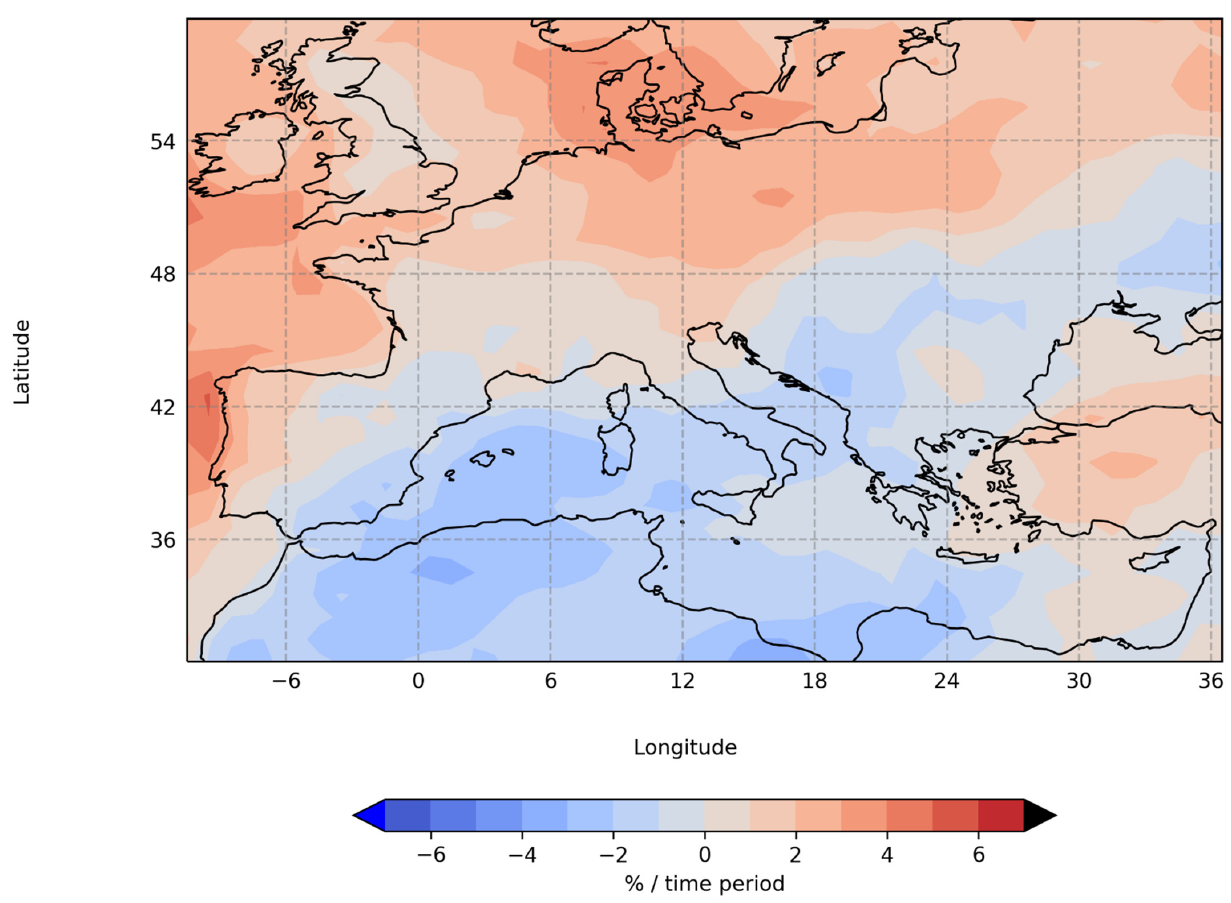
Figure 8. Similar to Figure 7 but for the total cloud fraction (CF) of the CRAAS dataset. The r 2 value of the linear regression fits averaged over the domain is equal to 0.011.